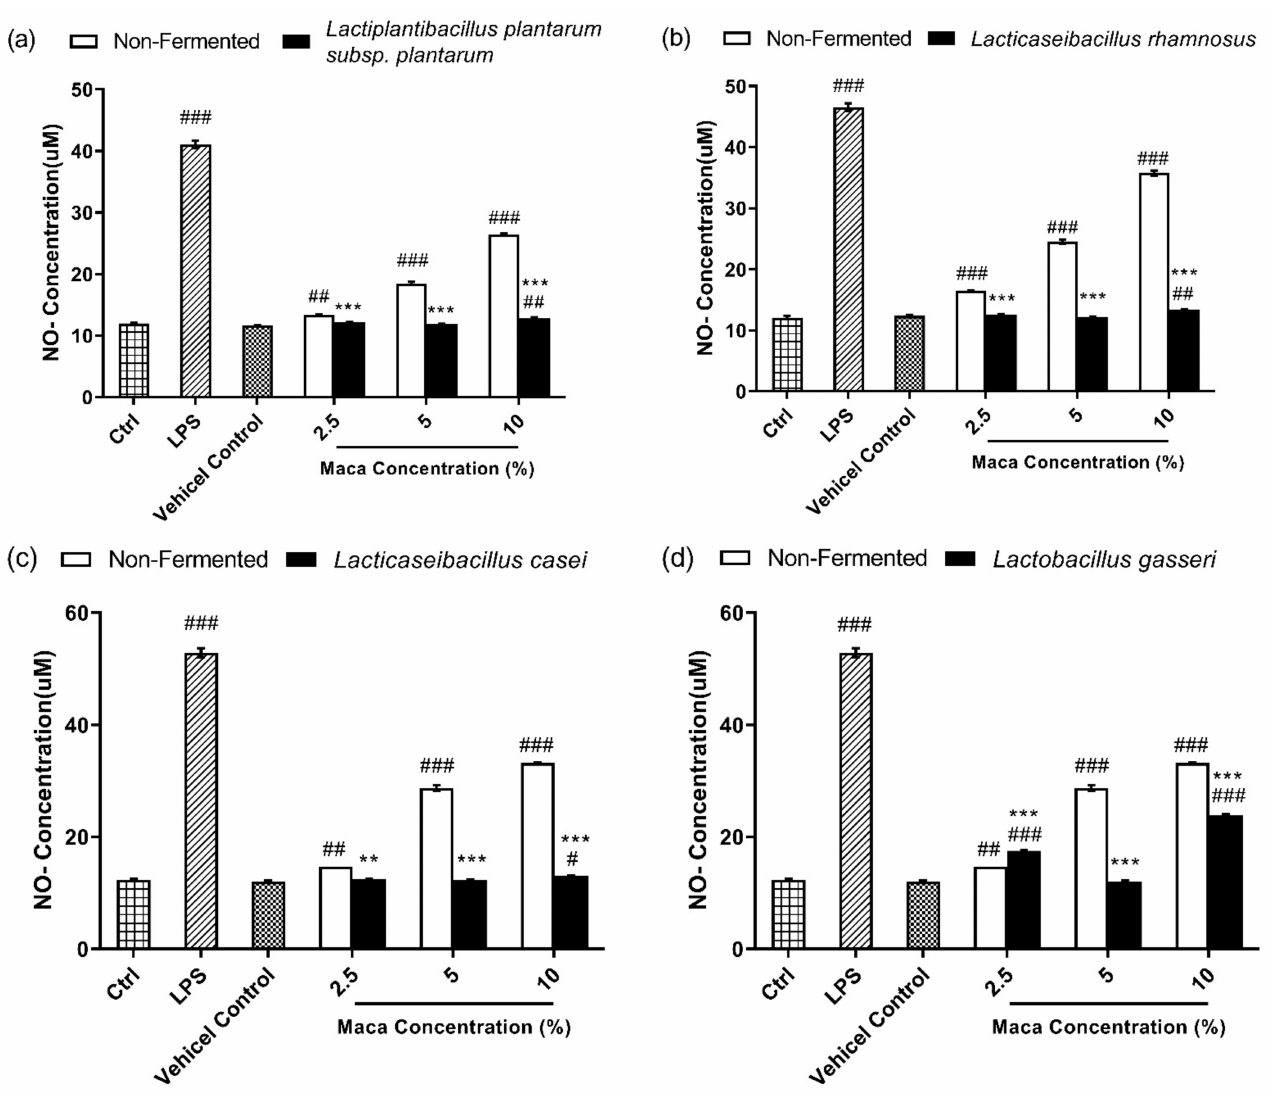
Figure 4. Effects of non-fermented and fermented maca root extracts on NO production in RAW 264.7 cells. NO concentrations in RAW 264.7 cells treated with maca root extracts fermented using ( a ) Lactiplantibacillus plantarum subsp. plantarum KCTC 3108, ( b ) Lacticaseibacillus rhamnosus KCTC 5033, ( c ) Lacticaseibacillus casei KCTC 3109, and ( d ) Lactobacillus gasseri KCTC 3143. Error bars, mean ± SD. # p < 0.05, ## p < 0.005, and ### p < 0.0005 compared to the control group, ** p < 0.005, *** p <